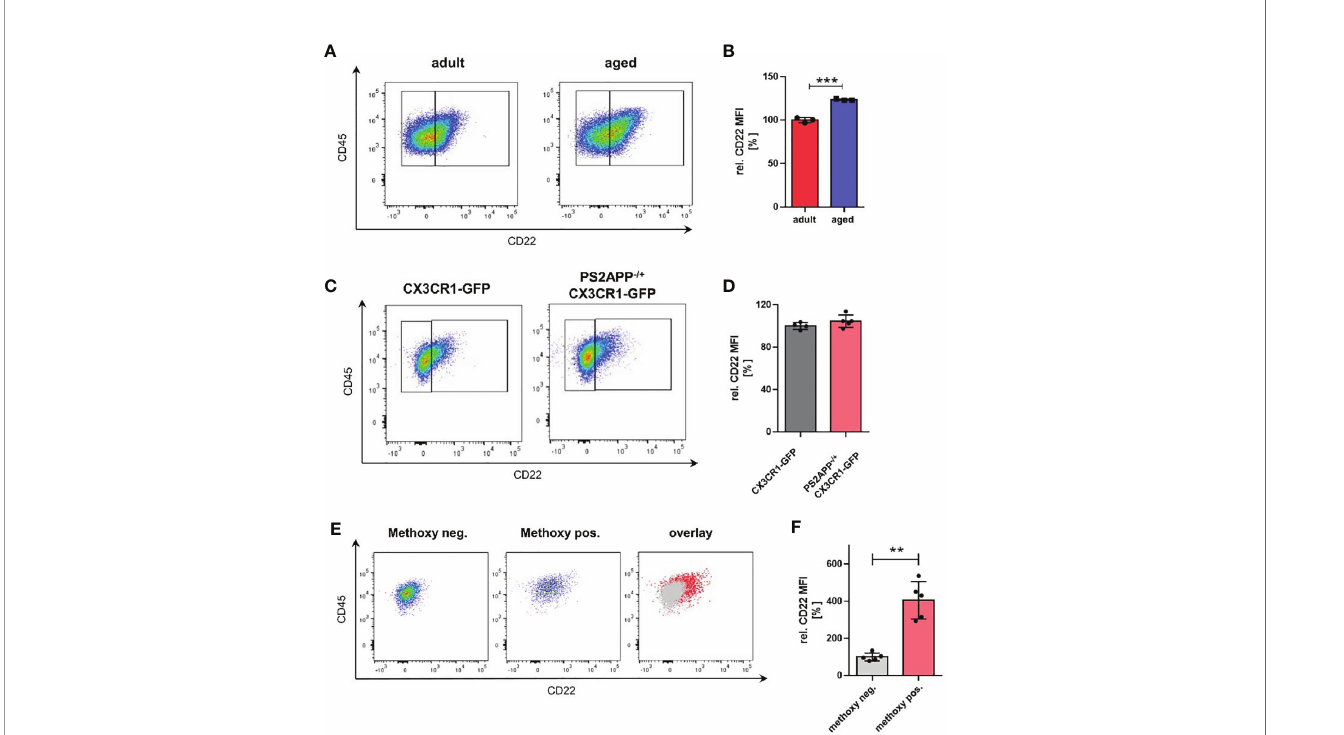
FIGURE 1 | Microglia from aged mice as well as A b -containing microglia exhibit an increased CD22 expression. (A) Representative fl ow cytometry scatter plots and (B) respective quanti fi cation showing the relative CD22 MFI of isolated microglia from adult (6 months) and aged (14-16 months) mice. n=3 mice per age. (C) Representative scatter plots and (D) quanti fi cation of the CD22 expression in isolated microglia from 13 months old PS2APP -/+ CX3CR1-GFP and age-matched CX3CR1-GFP mice. n=4-5 mice. (E) Scatter plots of CD22 expression in methoxy-X04 negative microglia, methoxy-04 positive microglia and an overlay visualizing the differences in CD22 signal between both subsets. (F) Relative CD22 MFI of methoxy-X04 negative and methoxy-04 positive microglia from 13 months old PS2APP CX3CR1-GFP mice. n=5, mean ± SEM. For (B, D) and (F) mean ± SEM, unpaired nonparametric t-test (Mann-Whitney). **p<0.01,